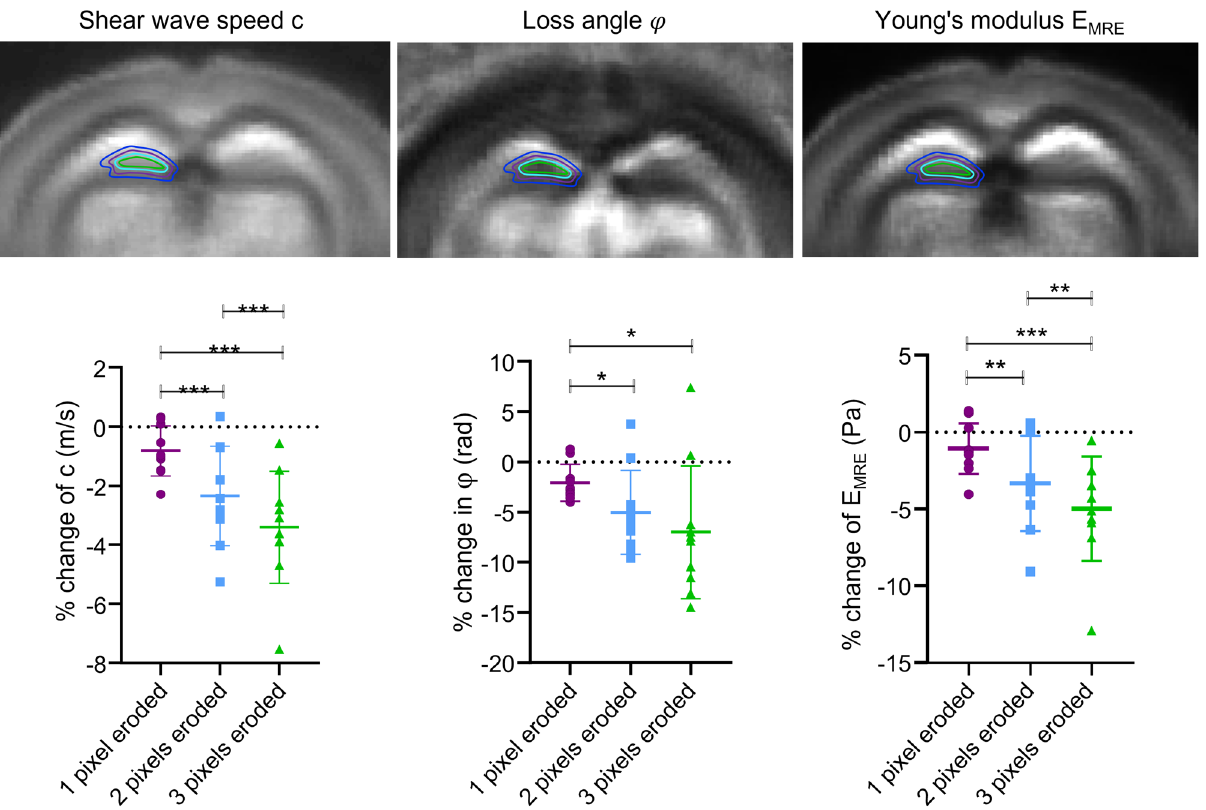
Figure 4. Eroding the dentate gyrus (DG) mask by 1, 2, and 3 pixels leads to significant decrease in viscoelastic parameters. Top, schematic mask of original DG and 1, 2, and 3 pixels eroded overlaid on averaged c-, φ- and EMRE-maps. Bottom, from left to right, percentage change in c (m/s) showing a significant decrease in c (m/s) when the DG mask is 1, 2 and 3 pixels (pixels) eroded (1 pixel eroded vs. 2 pixels eroded ***p = 0.0001, 1 pixel eroded vs. 3 pixels eroded ***p = 0.0001, 2 pixels eroded vs. 3 pixels eroded ***p = 0.0005); in the middle, percentage change in φ (rad) showing a significant decrease in φ (rad) when the DG mask is 2 and 3 pixels eroded (1 pixel eroded vs. 2 pixels eroded *p = 0.0108, 1 pixel eroded vs. 3 pixels eroded *p = 0.0270, 2 pixels eroded vs. 3 pixels eroded p = 0.0784); on the right, percentage change in EMRE (Pa) showing a significant decrease in E (Pa) when the DG mask is 1, 2 and 3 pixels eroded (1 pixel eroded vs. 2 pixels eroded **p = 0.0029, 1 pixel eroded vs. 3 pixels eroded ***p = 0.0004, 2 pixels eroded vs. 3 pixels eroded **p = 0.0046), n = 10.